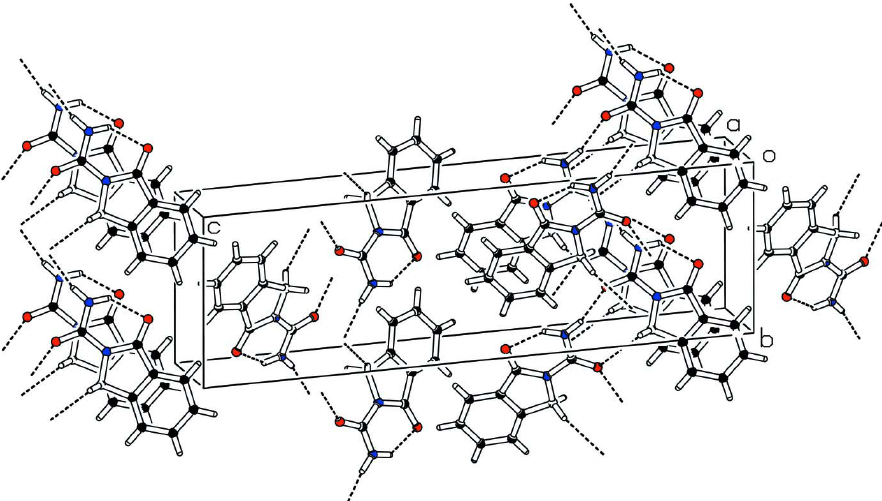
The packing figure ( PLATON : Spek, 2003) which shows the H-bonding and the π - π interaction. 1-Oxoisoindoline-2-carboxamide Crystal